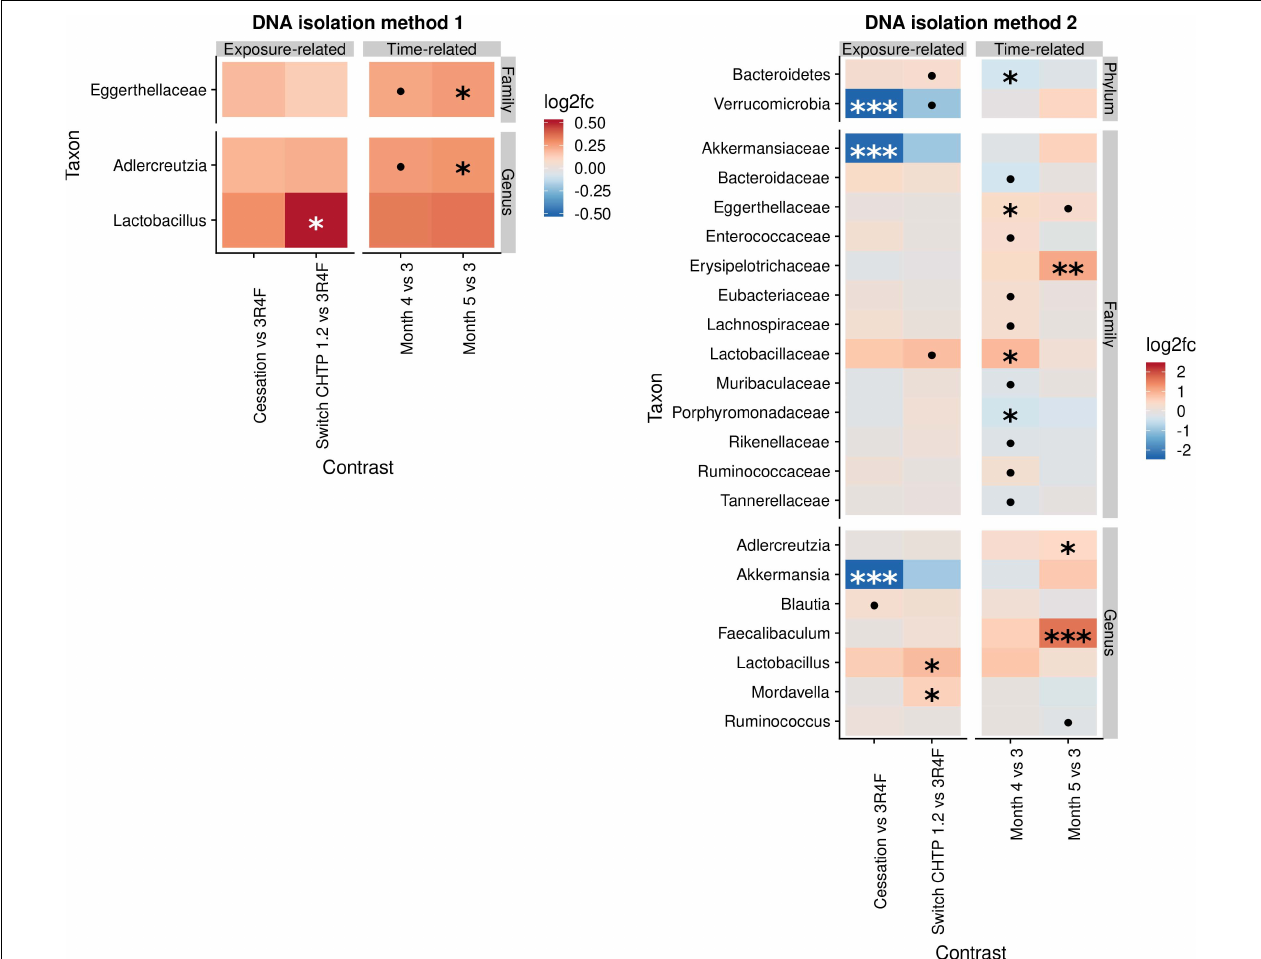
FIGURE 3 | Effects of cessation/switching to CHTP 1.2 relative to continued smoke exposure (lower). The intervention time point is at month 3. Fold-changes in the abundance of the various microbial taxa (y-axis) were modeled as a function of the exposure type relative to the CS exposure group, and the time point relative to the cessation/switching time point at month 3. Two methods of DNA isolation were used on different samples taken from the cages. Significance values are indicated as follows: *** p ≤ 0.001; **0.001 < p ≤ 0.01, *0.01 < p < 0.05; *0.05 < p <